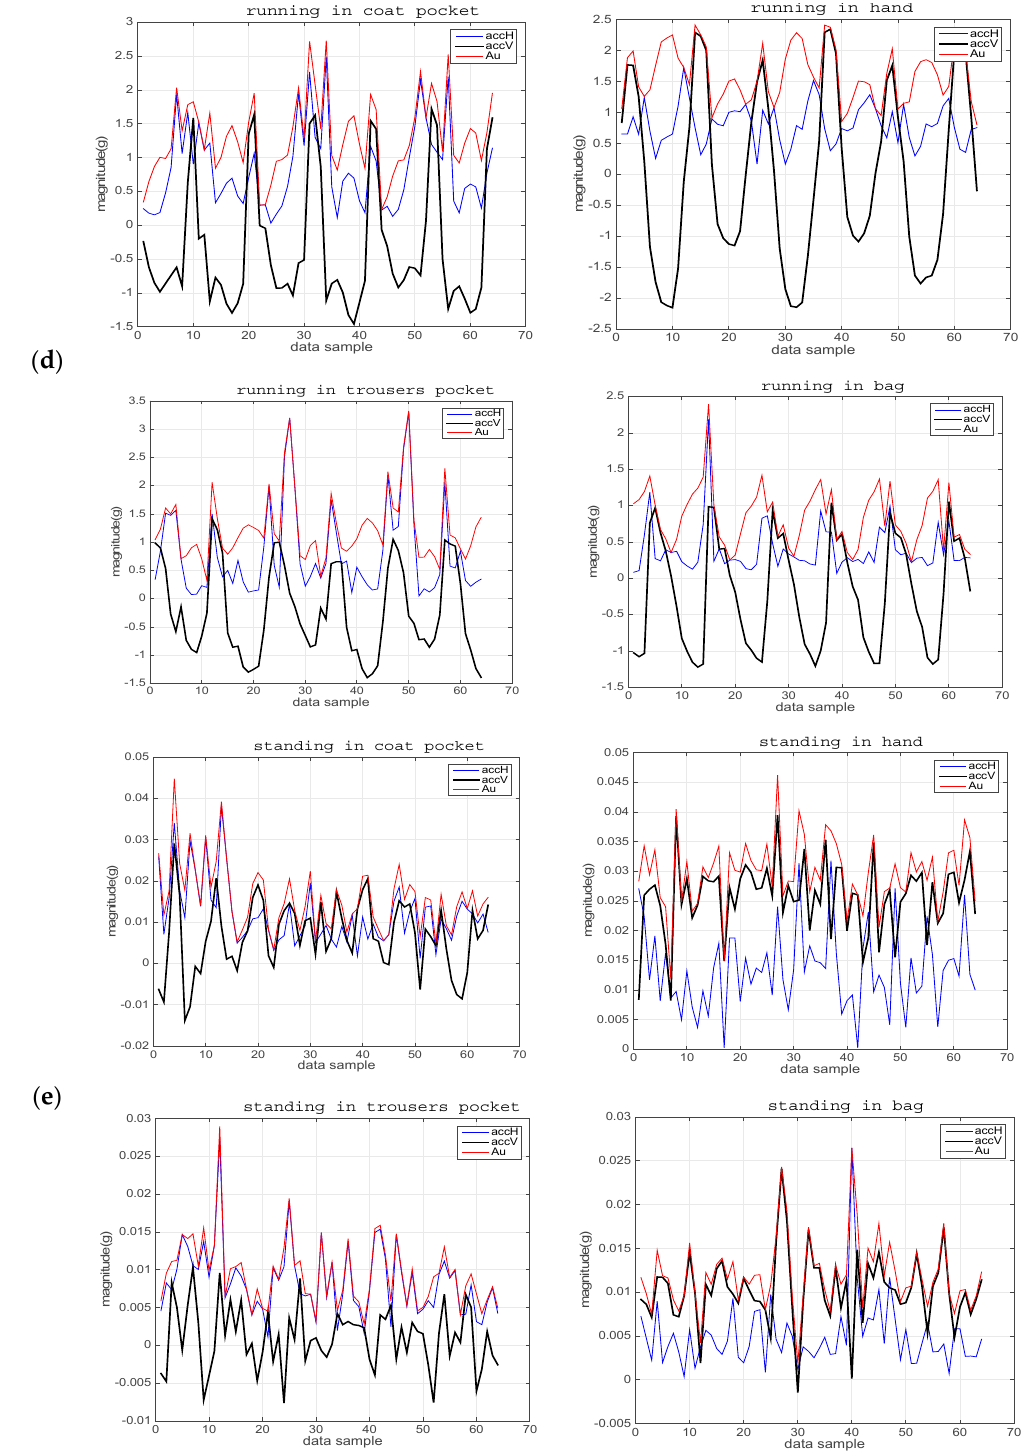
Figure 4. The waveforms of different activities in different positions: ( a ) Upstairs; ( b ) Downstairs; ( c ) Walking; ( d ) Running; ( e ) Standing.